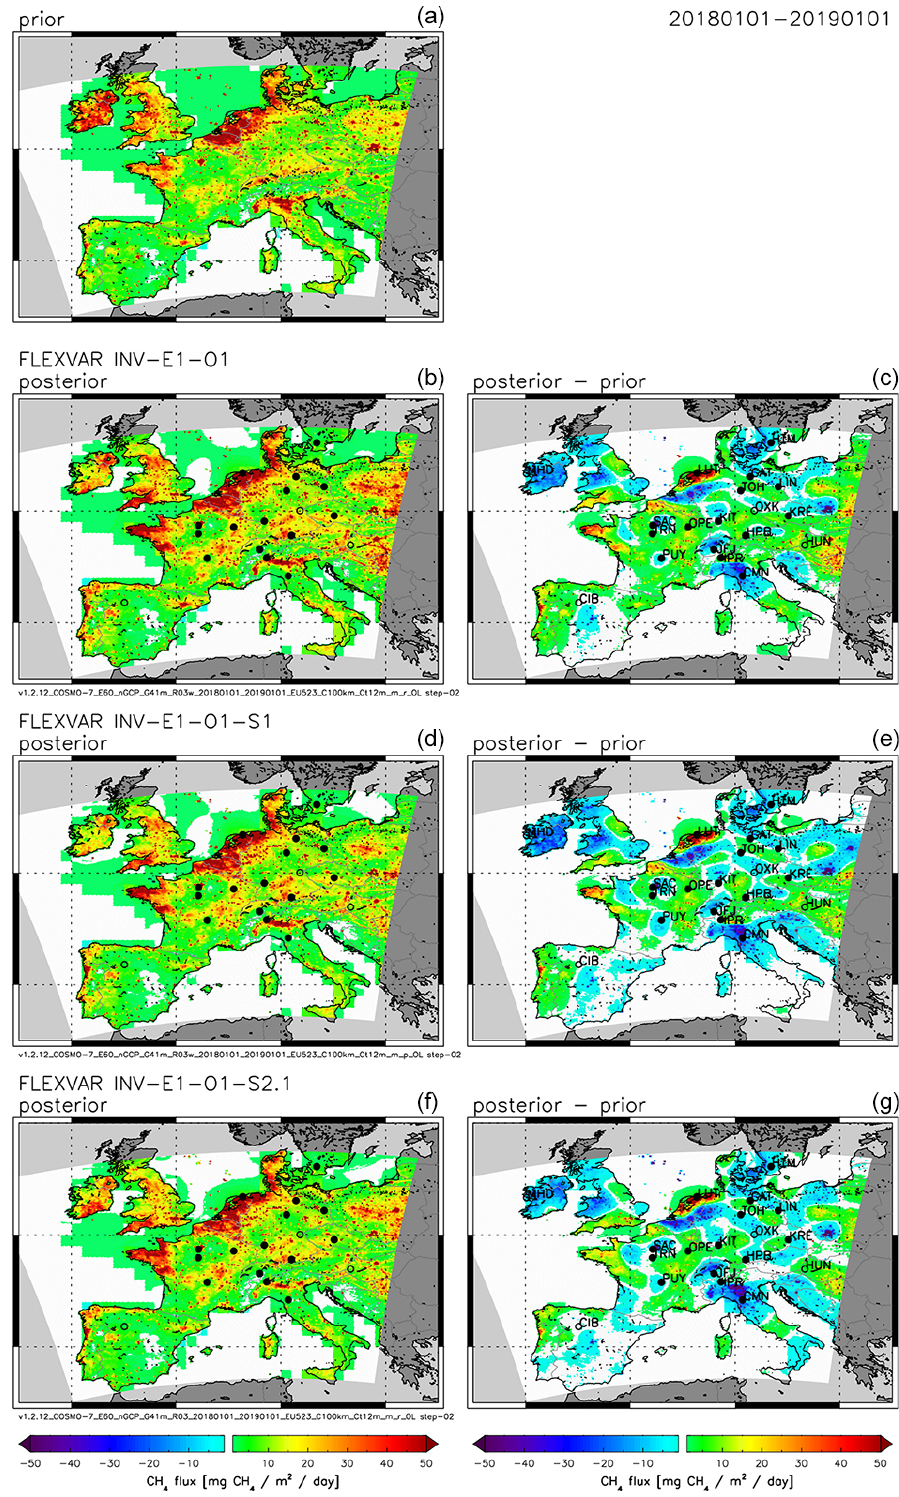
Figure 1. Sensitivity of FLEXVAR inversions to different approaches to calculate the baselines and to parameterize the model representation error. (a) Prior emissions (emission data set E1). (b, c) Posterior emissions (left) and difference between posterior and prior emissions (right) for base inversion INV-E1-O1 (using the Rödenbeck baselines and the METEO model representation error). (d, e) Inversion INV-E1-O1-S1 using the particle position baselines. (f, g) Inversion INV-E1-O1-S2.1 using the OBS model representation error. All figures show annual average CH 4 emissions (or change in emissions, respectively) for